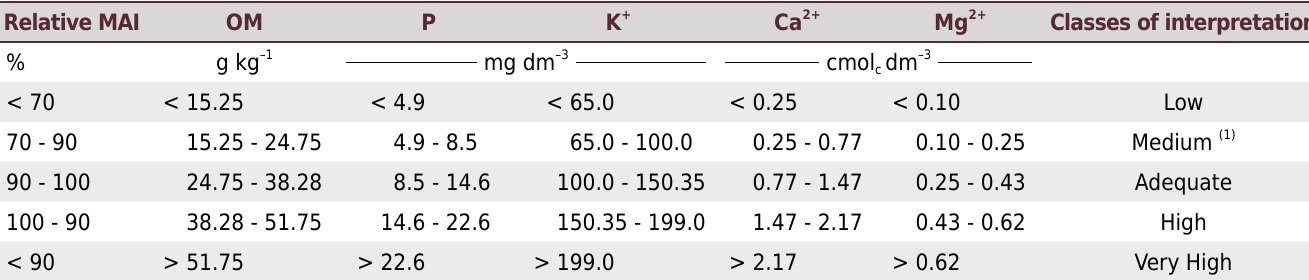
Table 2. Classes of interpretation of contents of organic matter (OM), phosphorus (P), potassium (K + ), calcium (Ca 2+ ) and magnesium (Mg 2+ ) in the soil estimated for the start of planting (0.00-0.20 m) for eucalyptus Relative